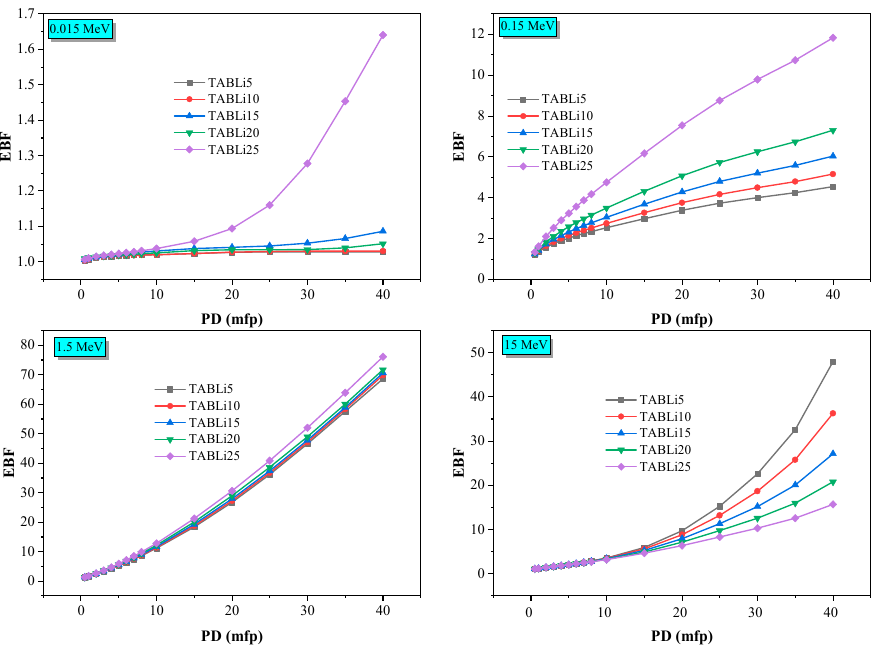
Figure 17. The exposure buildup factor (EBF) dependent on the penetration depth values (PD) at some fixed energies.